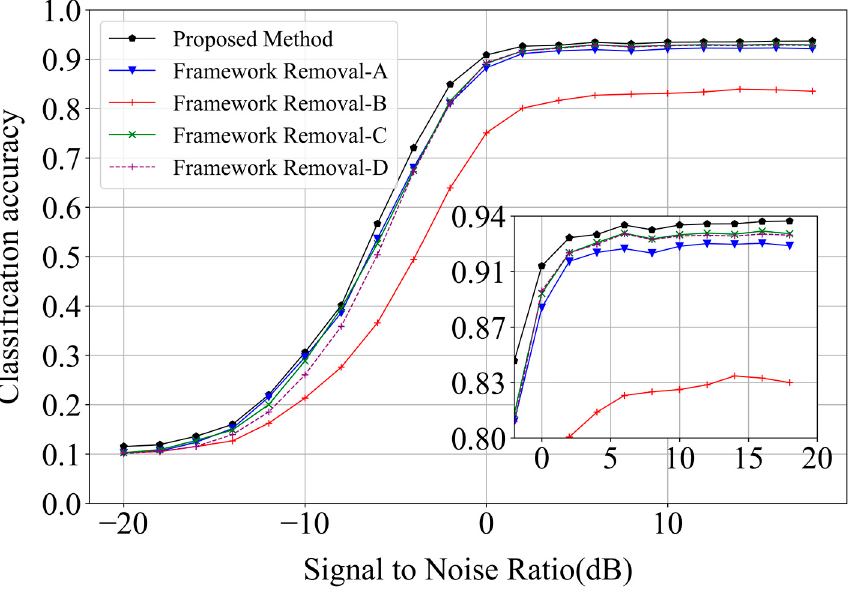
Figure 10. Influence of different neural network modules on recognition accuracy.